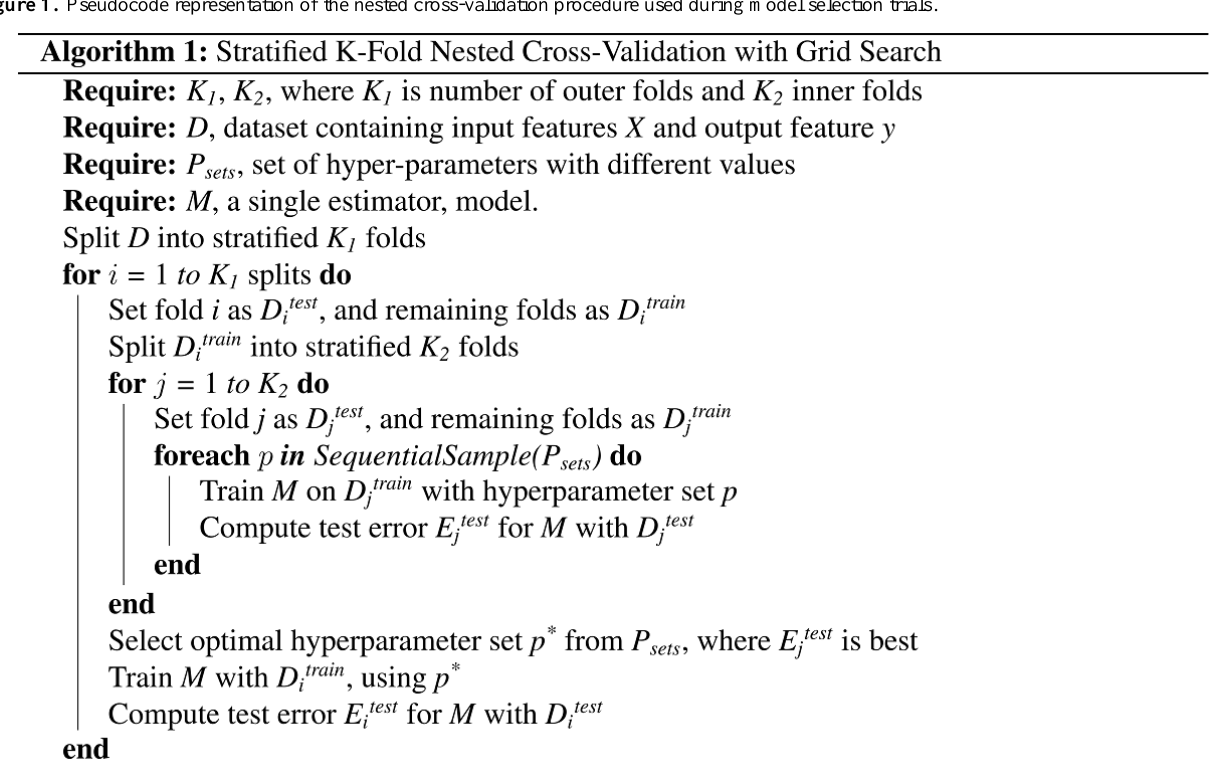
Figure 1. Pseudocode representation of the nested cross-validation procedure used during model selection